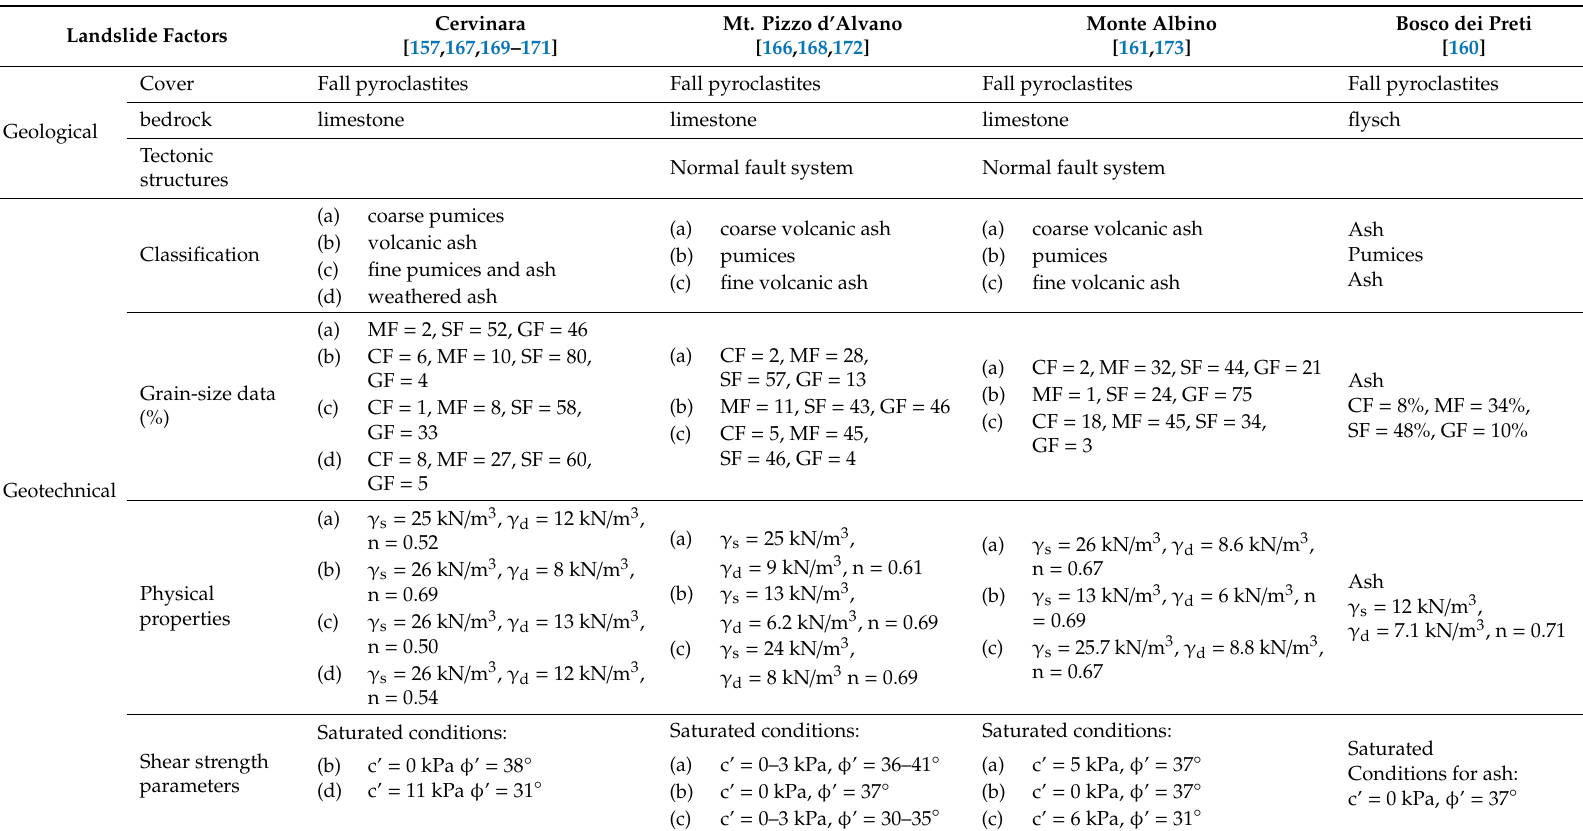
Table 8. Landslide factors of flows (class 6, Figure 11; [157,159–161,166–173]); Key: GF = gravel fraction; γ s = specific weight, γ d = volume unit weight, n = porosity, for the other geotechnical parameters referring to Tables 3 and